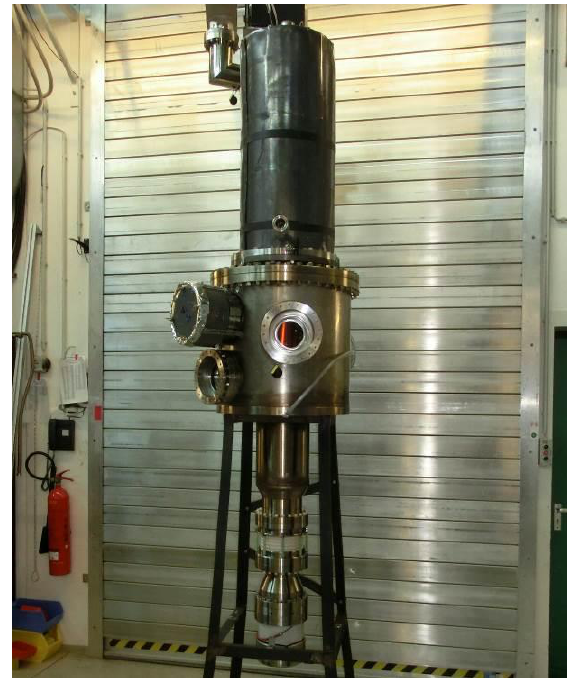
Fig. 1. The EU 1MW, 170 GHz SP gyrotron.